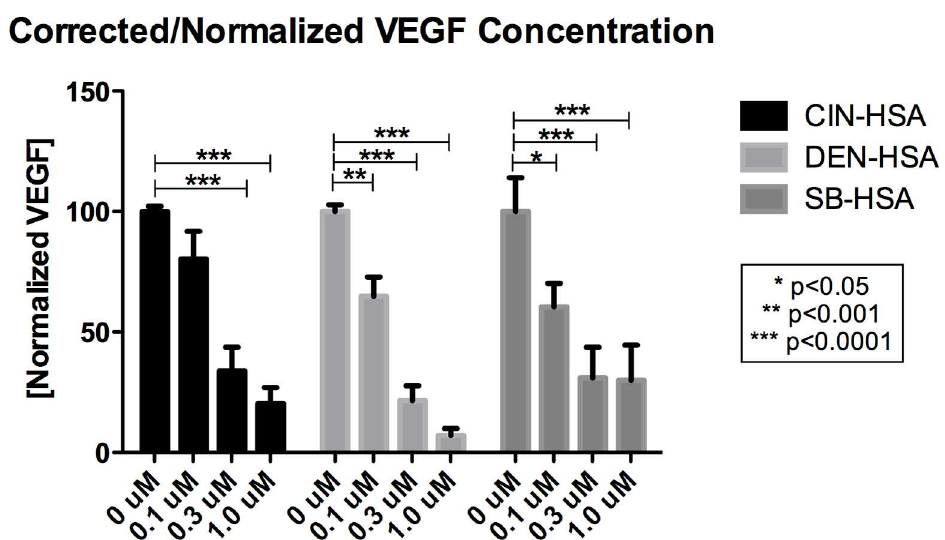
Fig 7. VDC-597 inhibits VEGF production in canine hemangiosarcoma cells. DEN, CIN, and SB-HSA cells were incubated in C/10 EMEM with various concentrations of VDC-597. 24 hours later, supernatants were harvested and utilized in a canine VEGF-specific ELISA. Relative viable cell number was concurrently assessed and VEGF concentration normalized to cell number. Error bars represent standard error measurements. Asterisks indicate P values less than